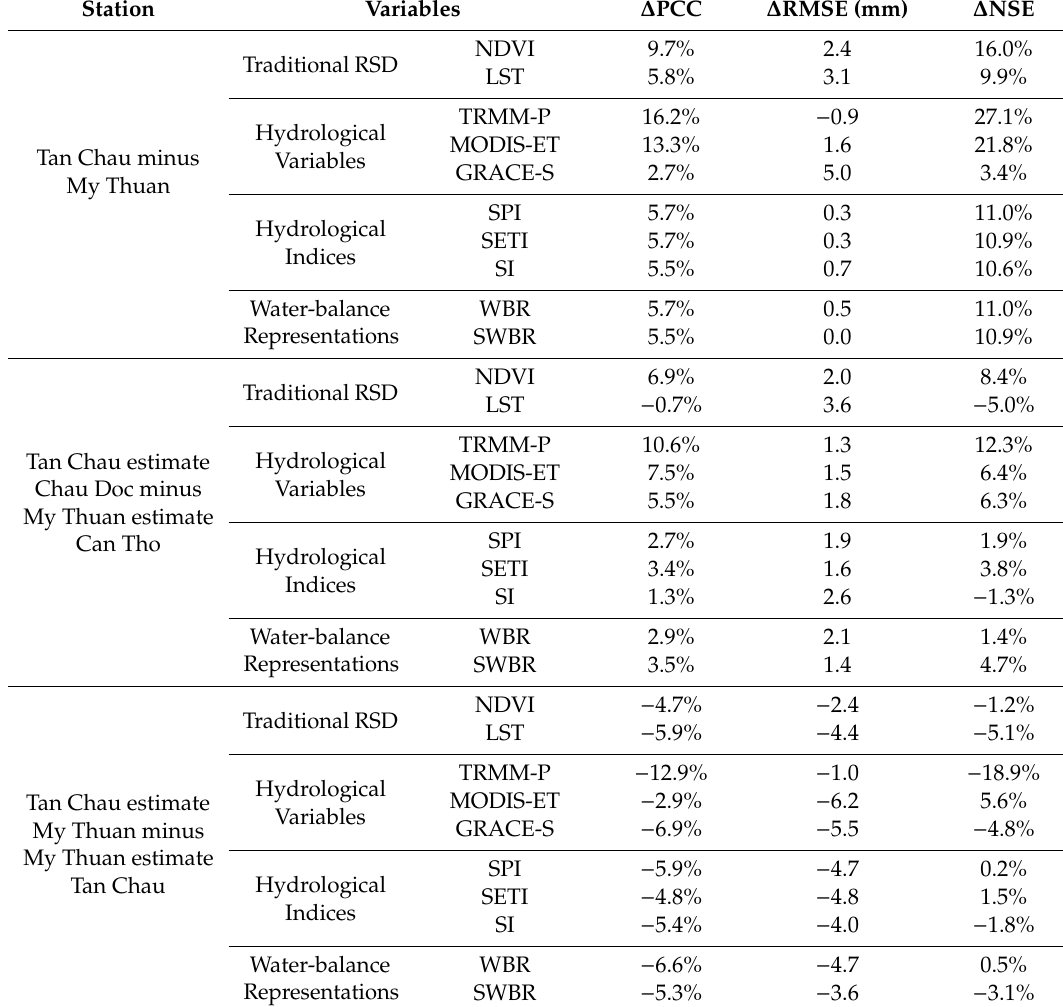
Table 4. Di ff erences in the result evaluation metrics between Tables 2 and 3. Pearson